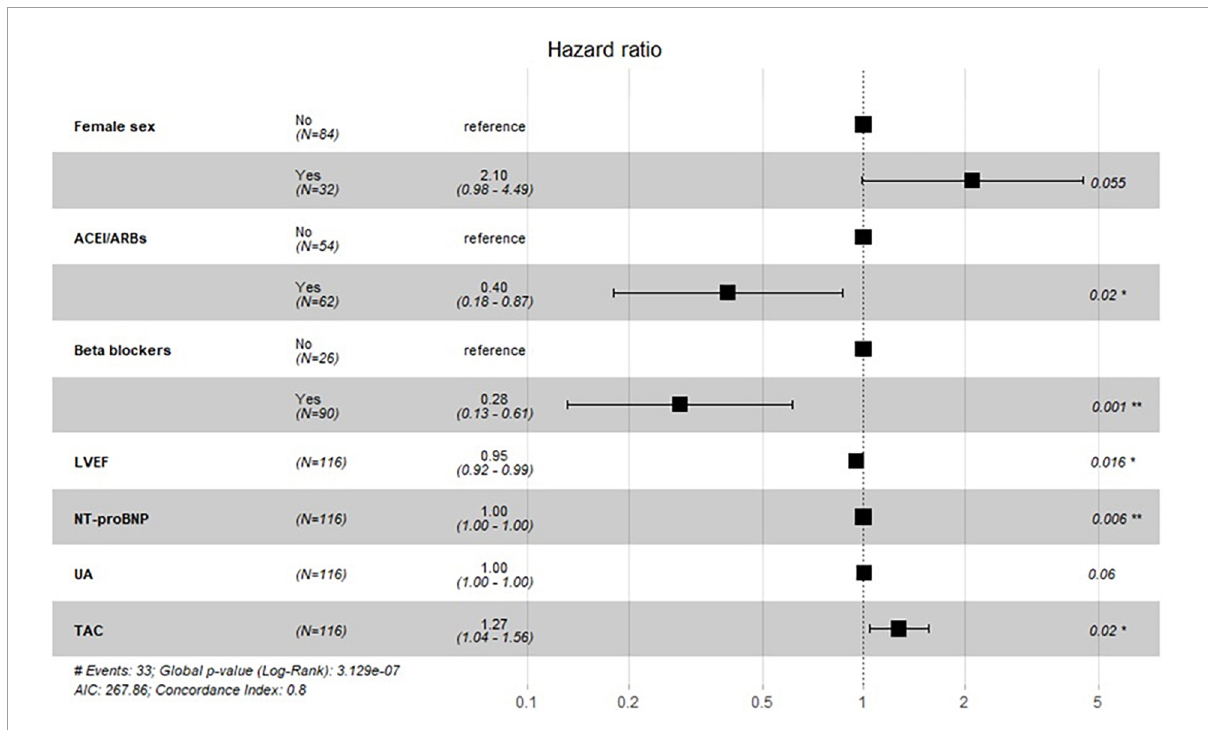
FIGURE2 Multivariable Cox regression for post-discharge mortality prediction.